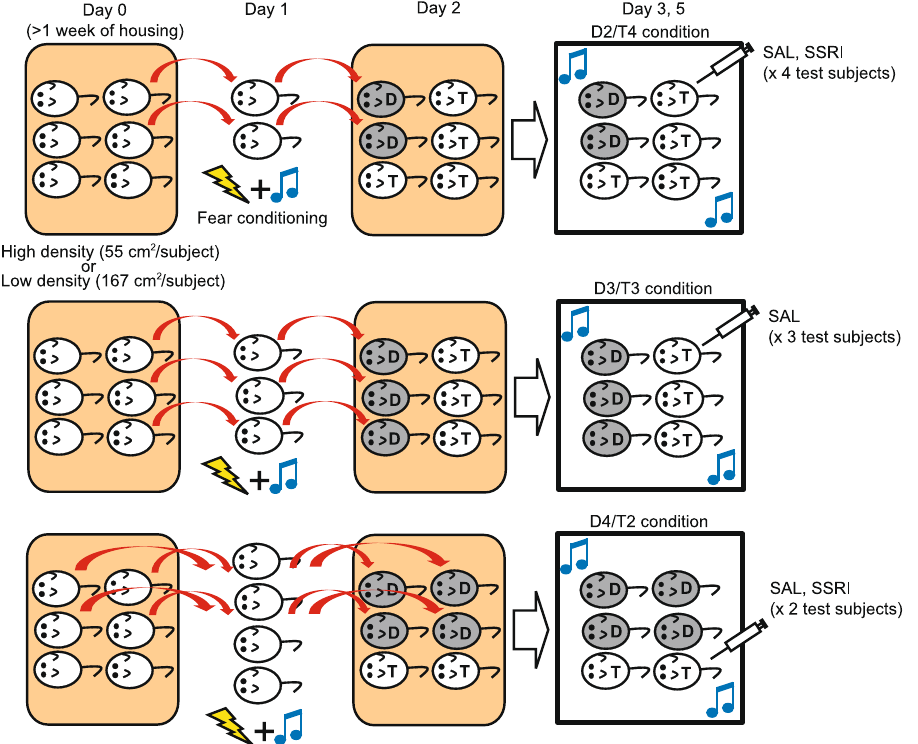
Figure 4. The behavioral test for decision-making under conflict associated with social conformity. Schematic diagrams illustrating the experimental design with different (D2/T4, D3/T3, and D4/T2) group